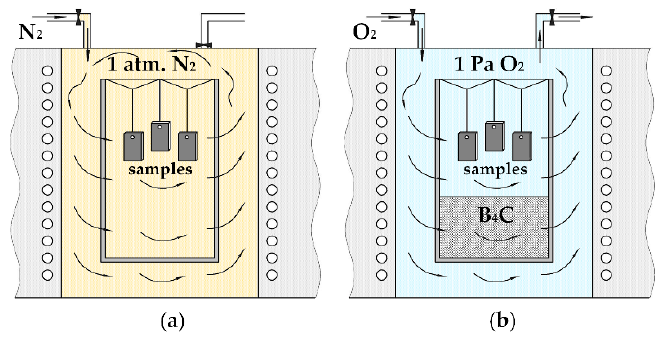
Figure 2. Scheme for fixing of samples during gas nitriding ( a ) and non-contact boriding ( b ).